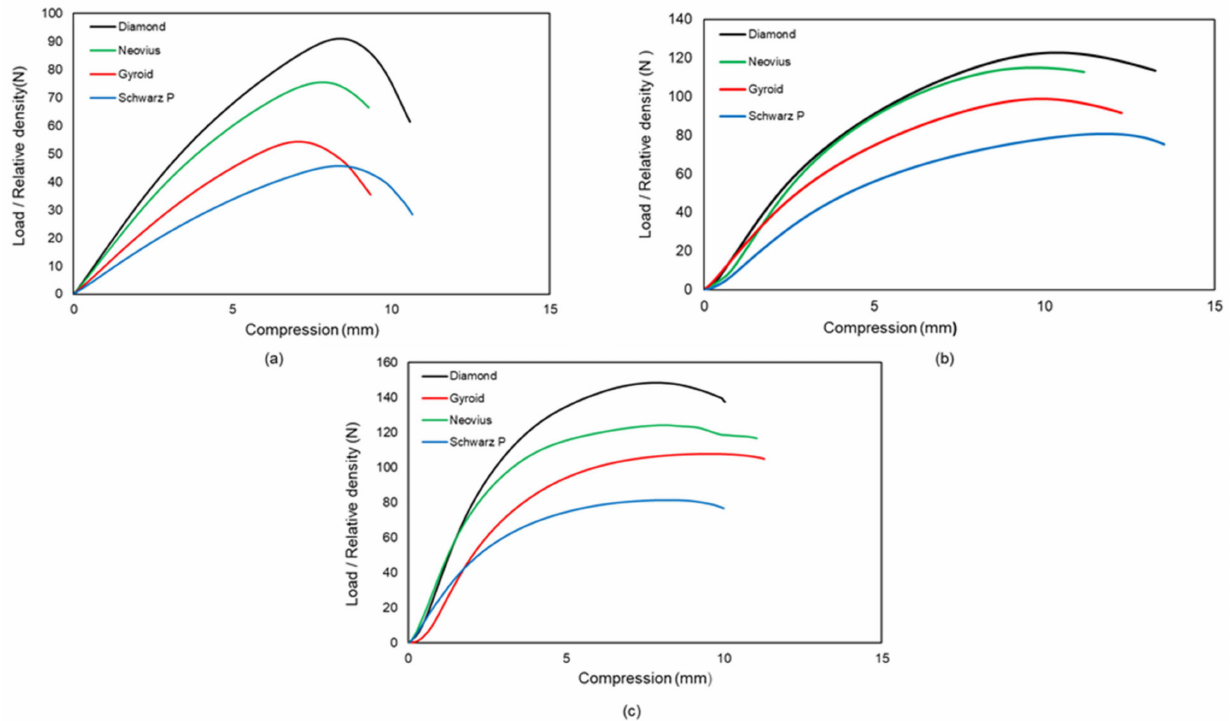
Figure 11. Regardless of relative density, the effect of lattice morphologies on critical buckling load. ( a ) Comparison of 2 × 2 × 16 configurations. ( b ) Comparison of 2 × 2 × 8 configurations. ( c ) Comparison of 2 × 2 × 4 configurations. The same result holds true for all three graphs: Diamond has the highest value, followed by Neovius and Gyroid, respectively, while Schwarz-P has the lowest